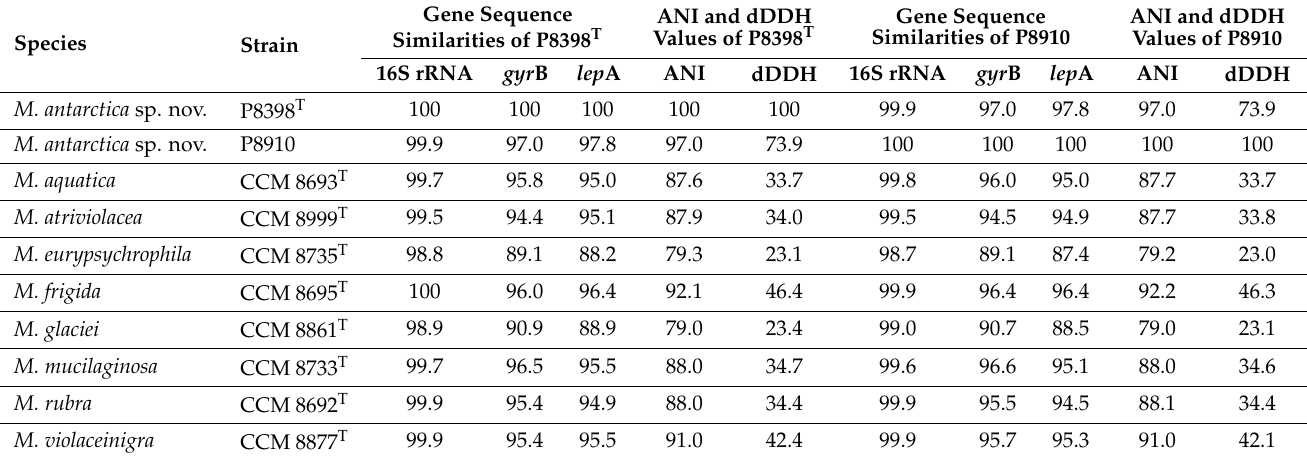
Table 2. Sequence similarity values of analysed genes, average nucleotide identities and the dDDH values (%) of Massilia antarctica sp. nov. reference strains P8398 T (= CCM 8941 T ) and P8910 (= CCM 9189) to related Massilia spp. All data were taken from this